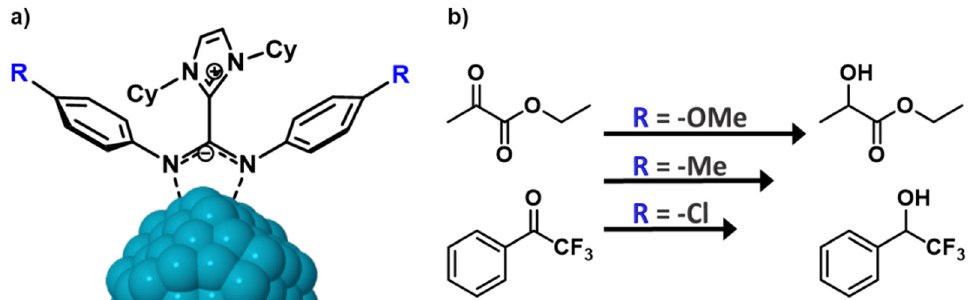
Figure 18. ( a ) Zwitterionic adduct of N,N ‐ dicyclohexylimidazolidene and diarylcarbodiimide ( a ) Zwitterionic adduct of N,N -dicyclohexylimidazolidene and diarylcarbodiimide (ICy ∙ (Ar) NCN; Ar = p ‐ tol, p ‐ anisyl, p ‐ ClC 6 H 4 ) coordinated to the MNP surface. ( b ) Ligand effect in the (ICy · (Ar) NCN; Ar = p-tol, p-anisyl, p-ClC 6 H 4 ) coordinated to the MNP surface. ( b ) Ligand e ff ect in the hydrogenation of activated ketones with Pt NPs stabilized by ICy ∙ (Ar) NCN. Reprinted with permission hydrogenation of activated ketones with Pt NPs stabilized by ICy · (Ar) NCN. Reprinted with permission from reference 70. Copyright 2020 Springer. from reference 70. Copyright 2020